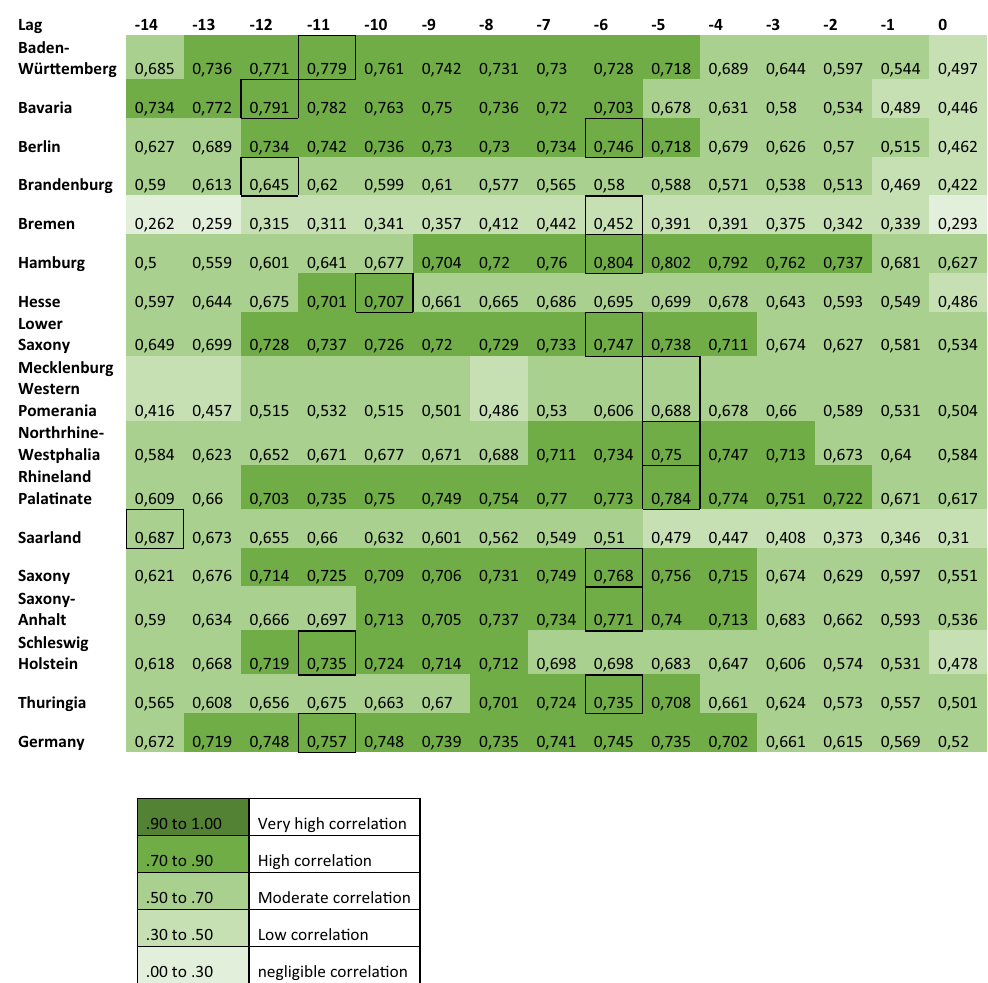
Figure 4. Cross-correlation coefficients displaying the linear association between the RSV of the term ‘corona’ and officially reported COVID-19